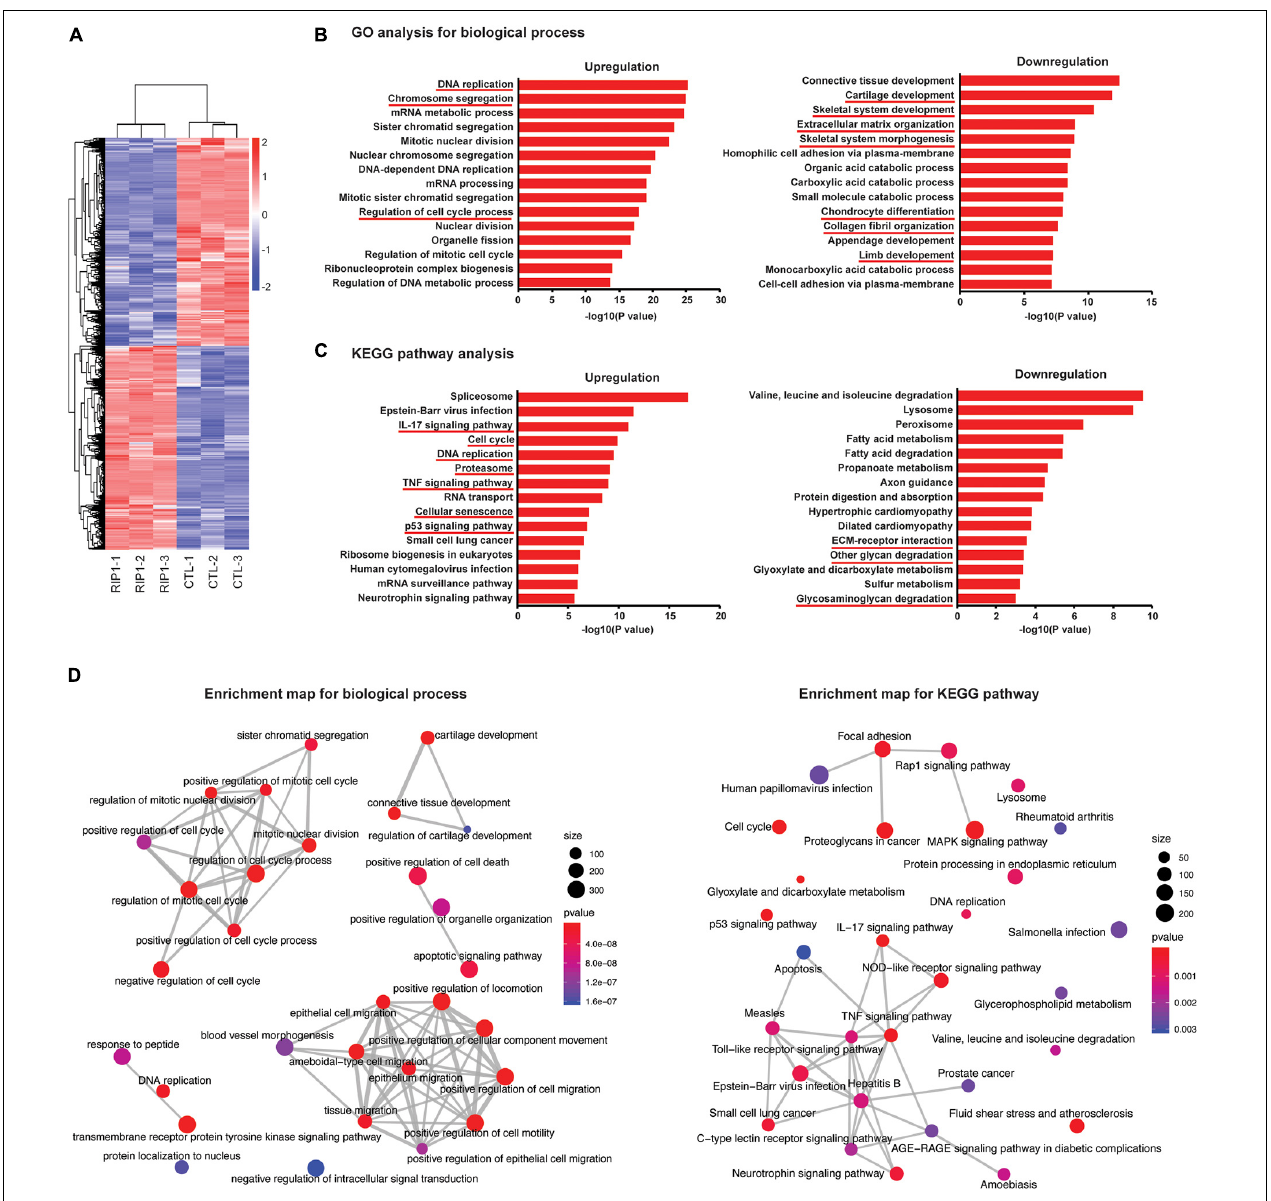
FIGURE 7 | Chondrocyte transcriptome after RIP1 overexpression determined by RNA-seq. (A) Heatmap of differential expressed genes in rat chondrocytes treated with Ad-Ctl (100 MOI) or Ad- Rip1 for 24 h ( n = 3 for each group). (B,C) GO analysis (B) and pathway analysis (C) for differentially expressed genes of rat chondrocyte transcriptome. (D) Enrichment map generated for graphical representations of top 30 enriched biological processes and KEGG